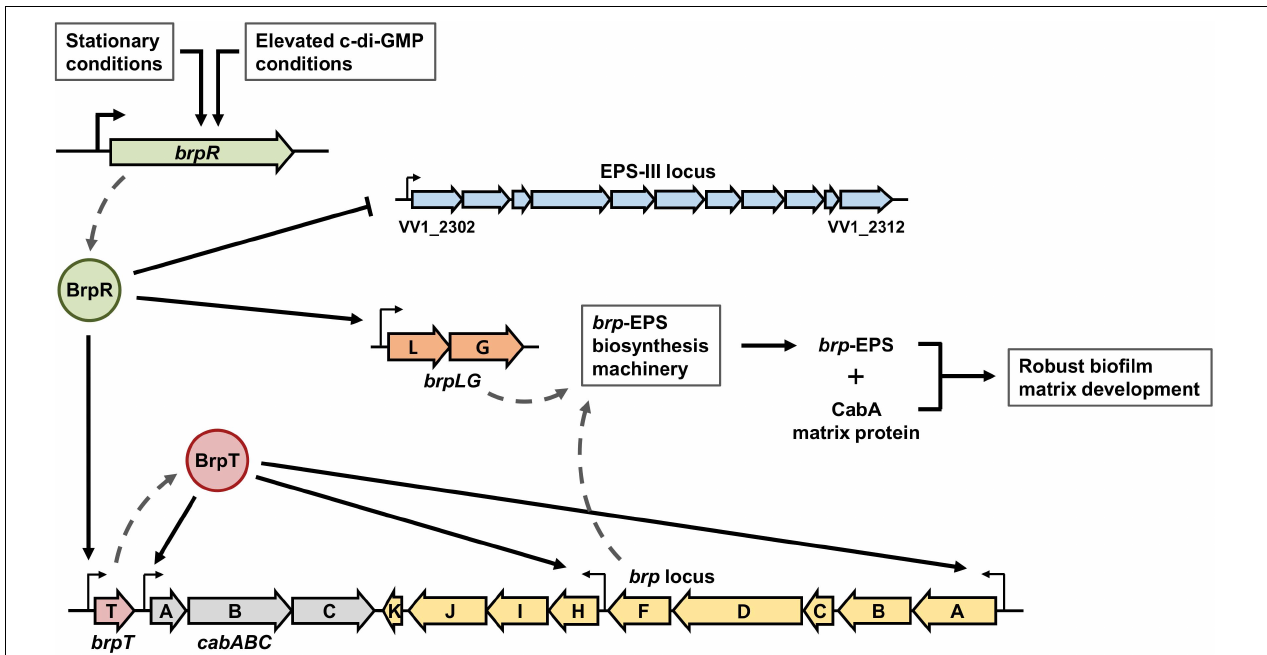
FIGURE 13 | BrpR-coordinated regulation of multiple loci for robust biofilm and rugose colony development in V. vulnificus . The stationary and elevated intracellular c-di-GMP conditions activate the brpR expression in V. vulnificus . BrpR subsequently represses the EPS-III locus but activates brpLG and brpT by directly binding to specific sequences in their upstream regions. BrpT then activates the cabABC operon and the brp locus. The proteins expressed from brpLG and the brp locus comprise the EPS biosynthesis machinery responsible for the brp -EPS production. The brp -EPS and the matrix protein CabA are secreted to the extracellular milieu and contribute to robust biofilm and rugose colony development of V. vulnificus